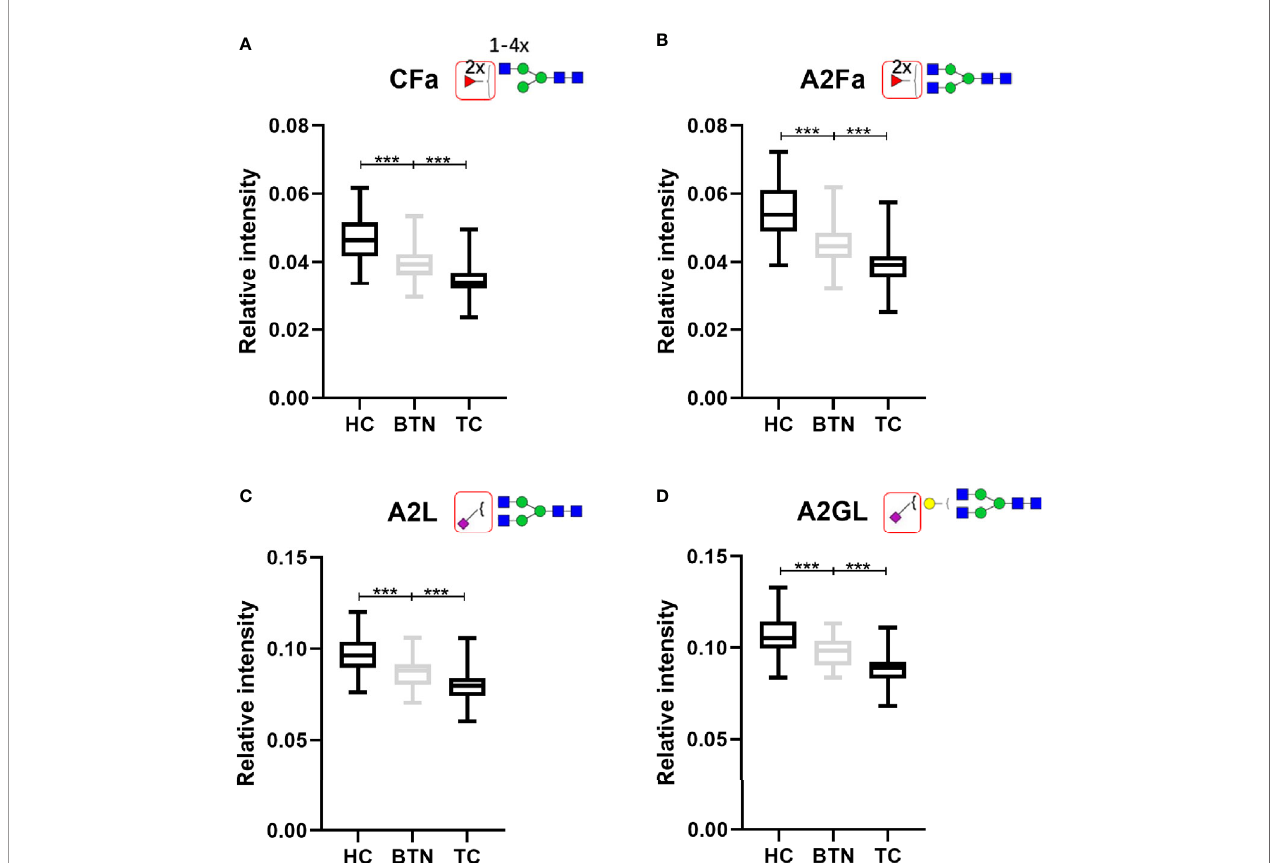
FIGURE 3 | The boxplots of derived glycan traits (A) CFa, (B) A2Fa, (C) A2L, and (D) A2GL, which showed consecutive changes in BTN and TC compared to HC. Numerical values indicate compositional limitations (i.e. 1-4 as the possible number of N-acetylhexosamines). Please see Supplemental Table S3 for more detailed derived glycan trait descriptions. Glycan trait abbreviations: C, within complex; Fa, species with 2 fucoses (i.e. at least one antennary fucose); A2, diantennary; L, a 2,3-linked sialylation; G, galactose. *** represents p-value < 0.001 (after multiple testing correction).